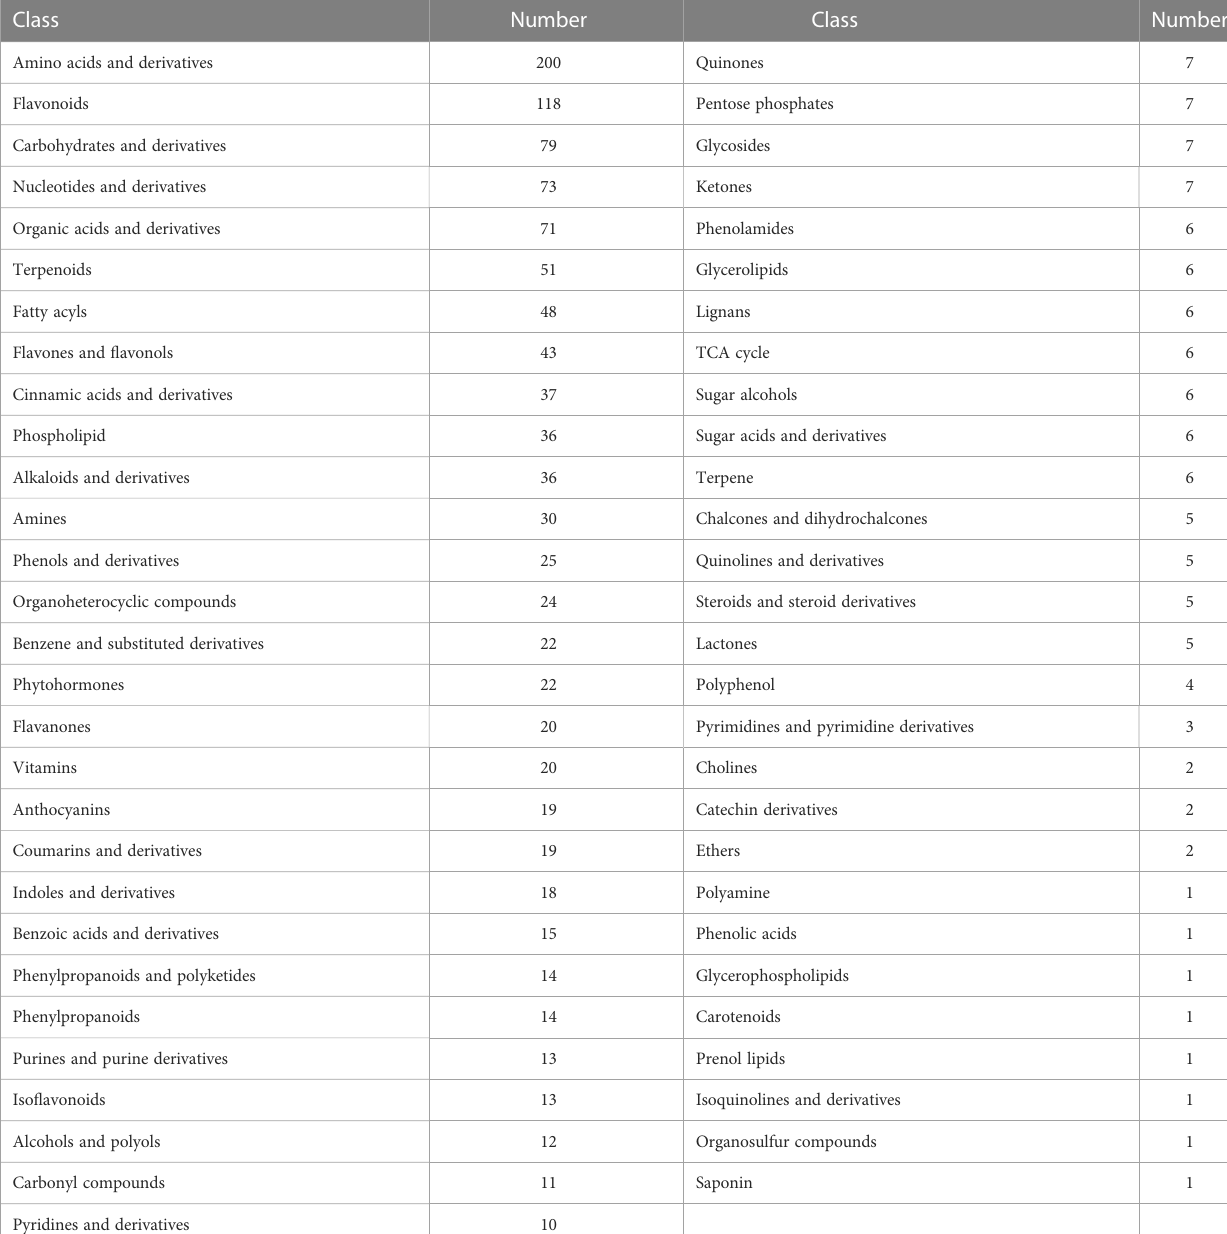
TABLE 1 The type and quantity of identi fi ed metabolites between CK and